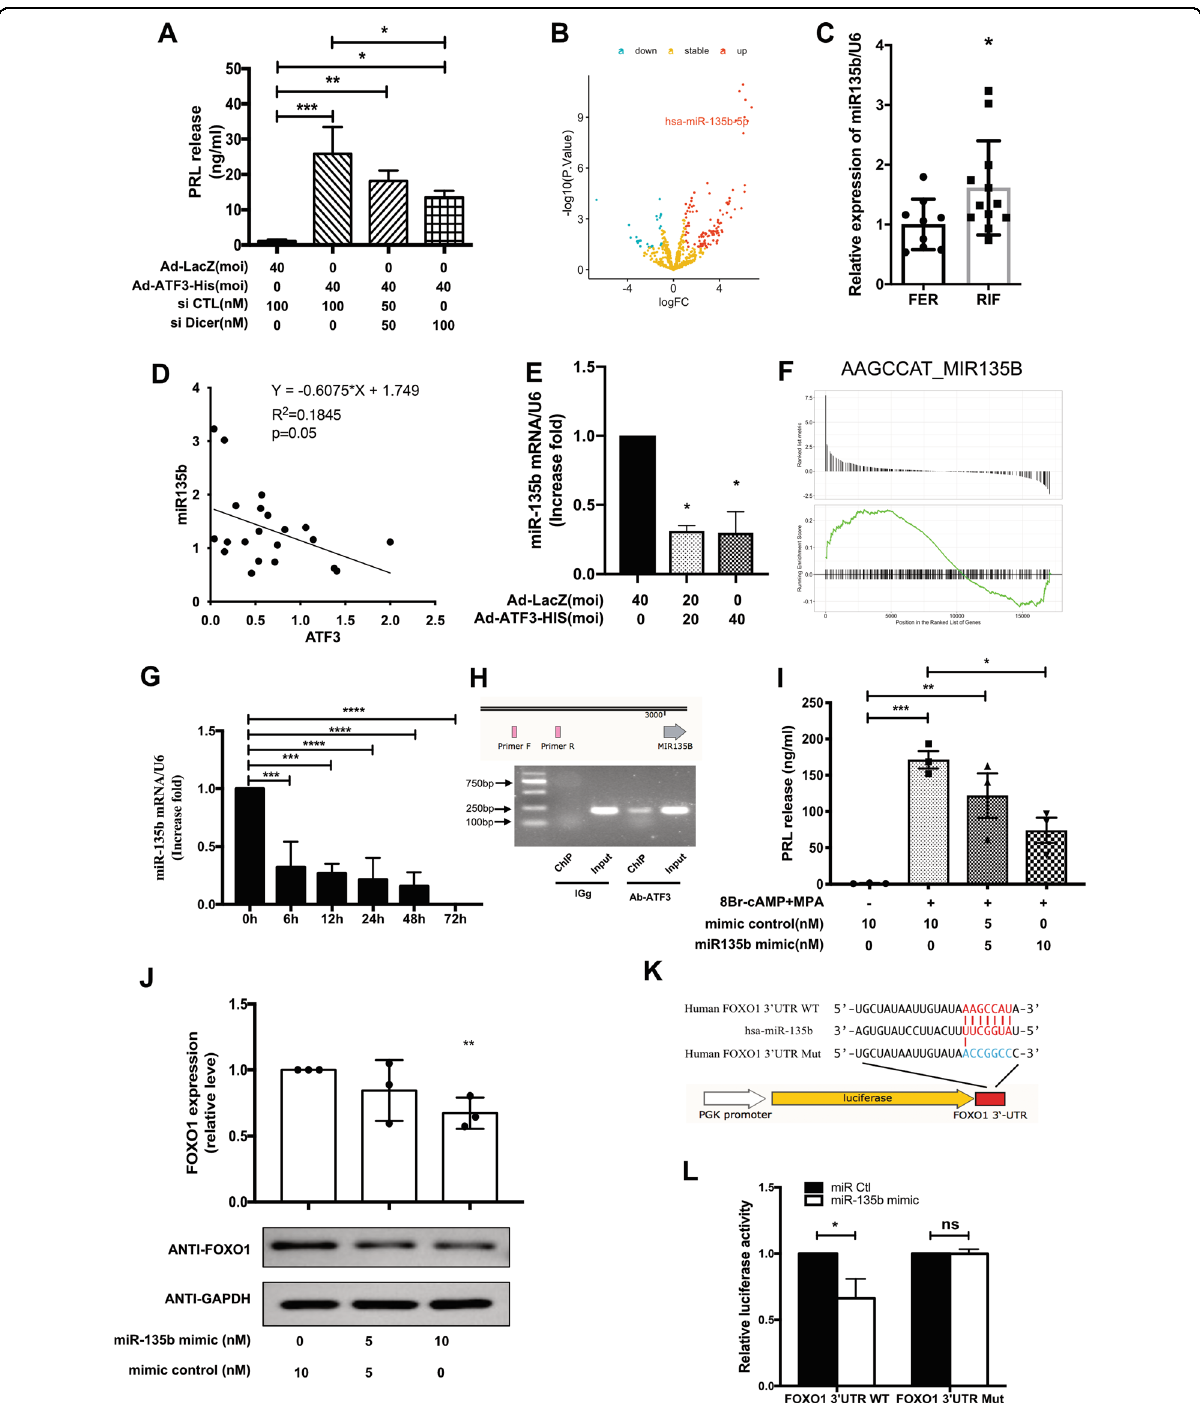
Fig. 5 (See legend on next